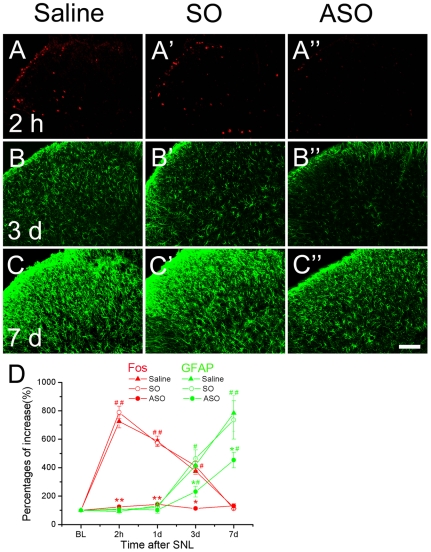
The expressions of Fos and GFAP in the ipsilateral dorsal horn in saline, c-fos SO and ASO groups after SNL.Compared to saline or c-fos SO treated group, c-fos ASO produced a significant inhibitory effect on Fos protein expression (A–A″), as well as on astrocytic activation (B–B″, C–C″) in the spinal dorsal horn. D, Statistics of the time course study. The baseline level of Fos and GFAP was set as 100%, respectively. The changing course of Fos (red curves) or GFAP (green curves) was determined with comparison to the relative baseline value. The relative increase in the number of Fos-positive neurons reached a peak 2 h in the SO and saline group, then fell back quickly to the normal level in 1 w. However, Fos expression was maintained at the baseline level by ASO treatment. The GFAP expression presented a different changing course tendency: increasing since day 3 and keeping a high level 1 w after SNL. Interestingly, the increase of GFAP expression was interfered with by ASO treatment on day 3 and 7. #, P<0.05 and # #, P<0.01, as compared to the baseline value; *, P<0.05 and **, P<0.01, as compared to the saline control in the same time point. Scale bar = 200 µm.